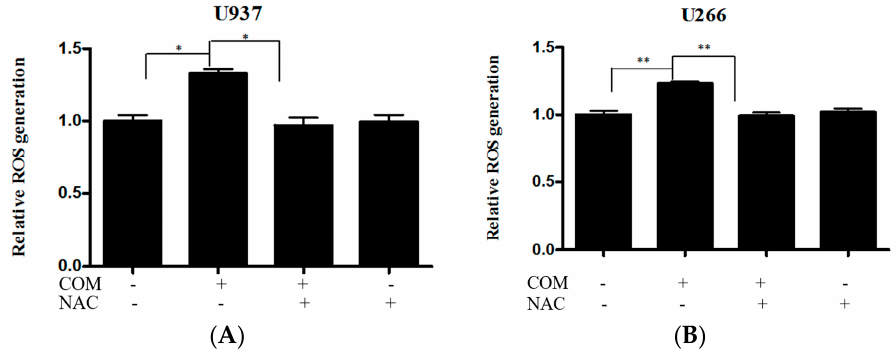
Figure 4. The effect of COM on ROS production in U937 and U266 cells. ( A ) U937 cells were treated with COM (80 µg/mL) for 24 h with or without pre-treatment with NAC (5 mM) for 1 h. ROS production was analyzed using oxidation-sensitive fluorescent dye (DCFDA) by cellular reactive oxygen species detection assay kit; ( B ) U266 cells treated under the same conditions. Values represent the means of three experiments ± SD; * p < 0.05, ** p < 0.01, versus untreated control.